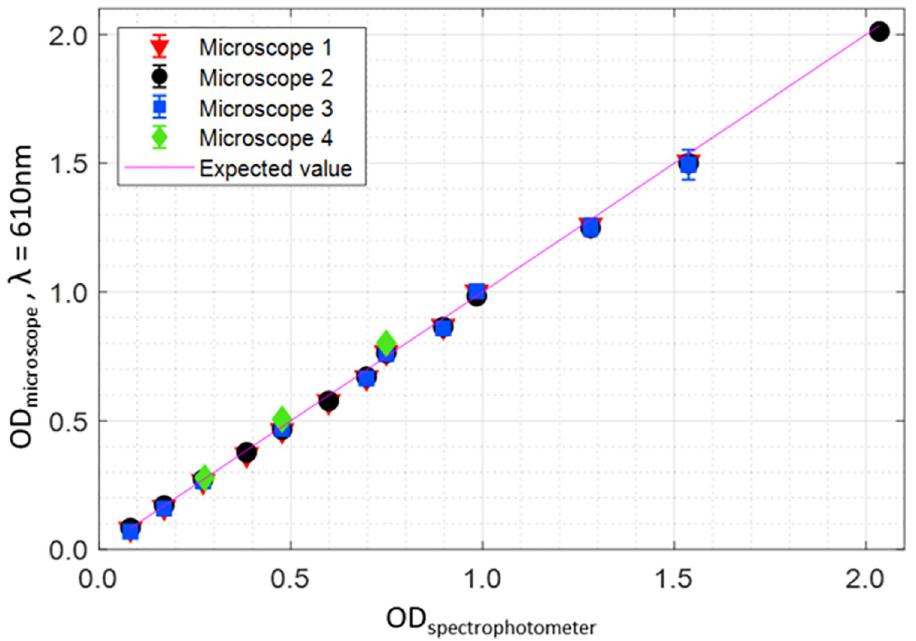
Fig 2. Validation of absorbance microscopy method. Absorbance microscopy data of ND filters plotted against the measured OD values using a spectrophotometer (average OD at λ = 598 to 622 nm). There is a strong correlation between OD measured by each microscope and the spectrophotometer indicating that the brightfield microscopy can be used to achieve comparable absorbance measurements even when microscopy instruments differ. Imaging was performed using four different microscopes equipped with different cameras and a 610 nm bandpass filter. The error bars represent the standard deviation.